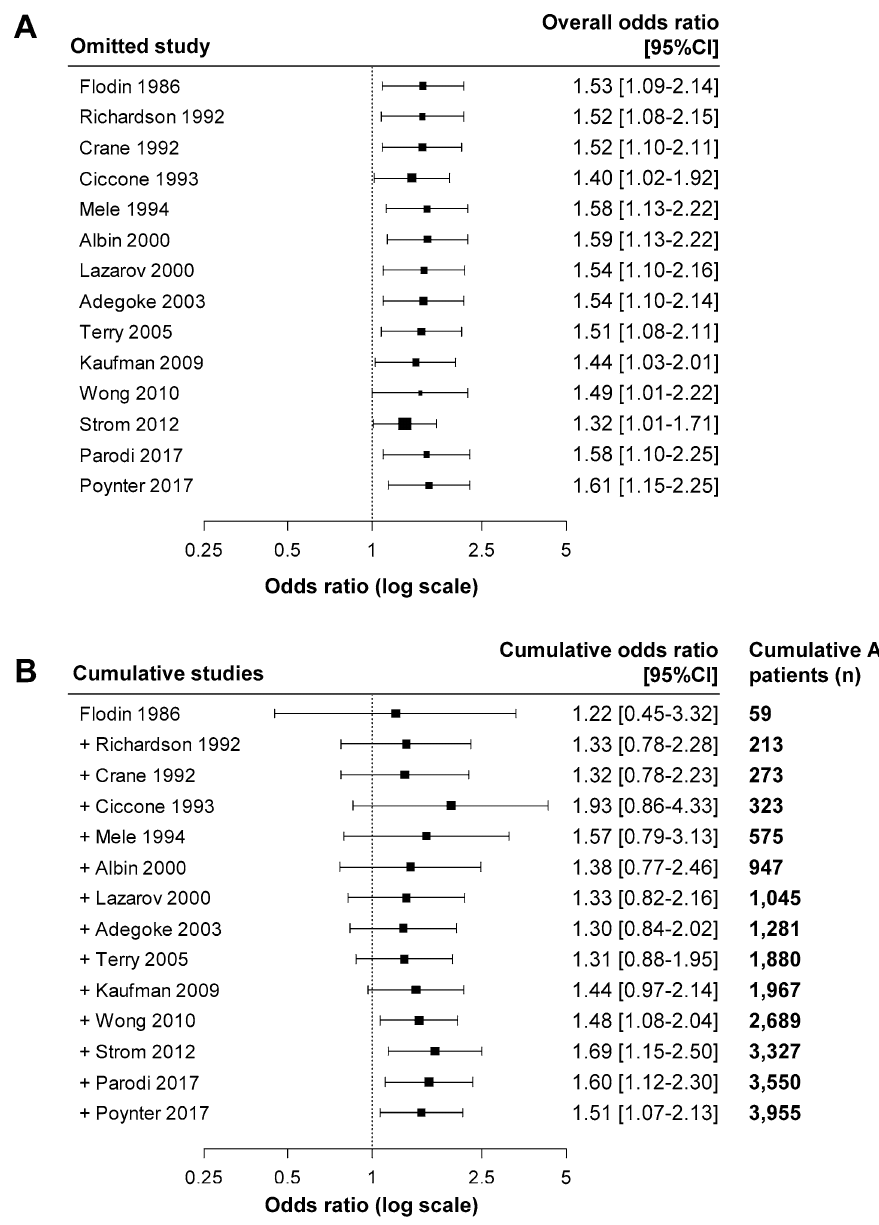
Figure 4. Sensitivity and time-dependent cumulative analyses. ( A ) Sensitivity analysis by sequential omission of every study. Each line refers to the global odds ratio (OR) after excluding the corresponding study. In all cases, the OR is statistically significantly in favor of a risk of developing acute myeloid leukemia (AML) related to occupational pesticide exposure (OPE). ( B ) Time-dependent analyses after adding each study down to the full 14 publications. The OR, in favor of AML risk related to OPE, becomes statistically significant after the cumulative inclusion of 2,689 patients (from Wong O et al.). This figure was performed using R software 30 with the “metafor” package 28